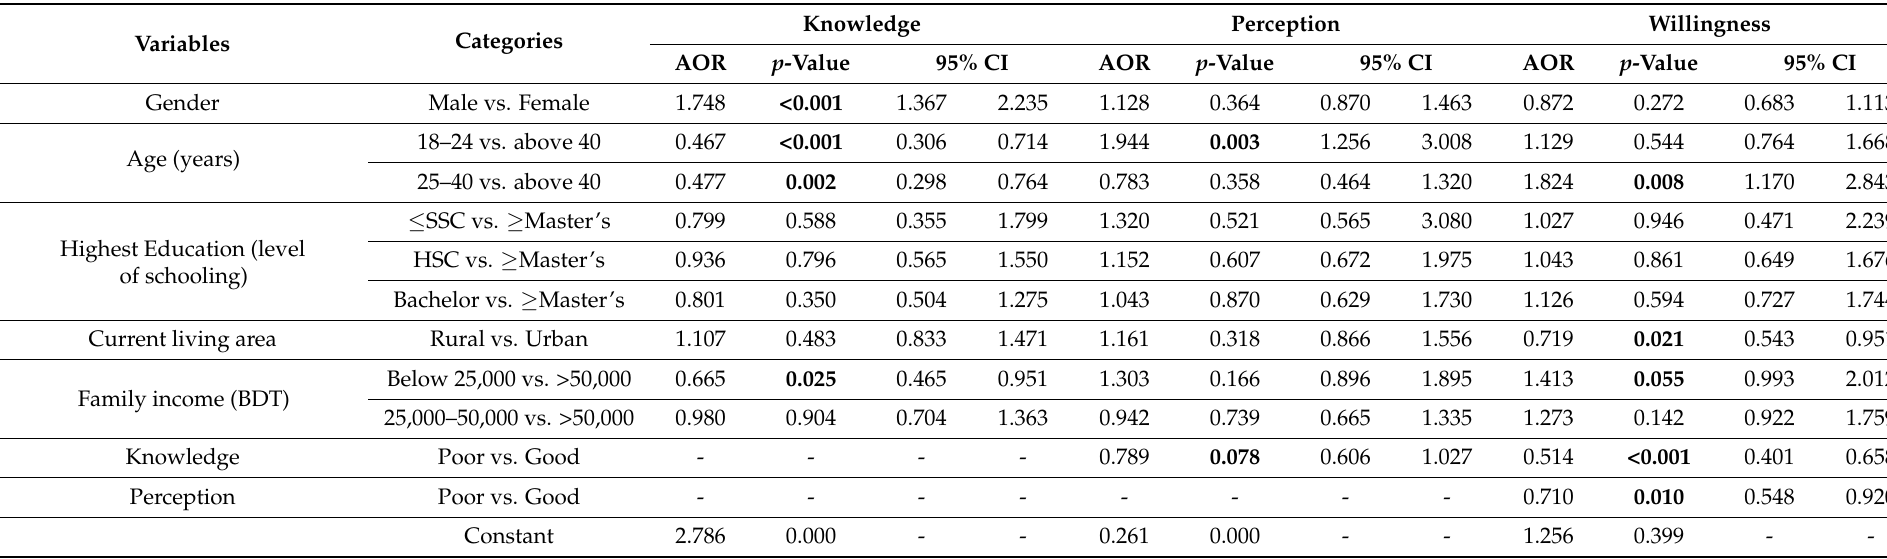
Table 3. Logistic regression analysis of knowledge, perception, and willingness to get COVID-19 vaccine of general population of